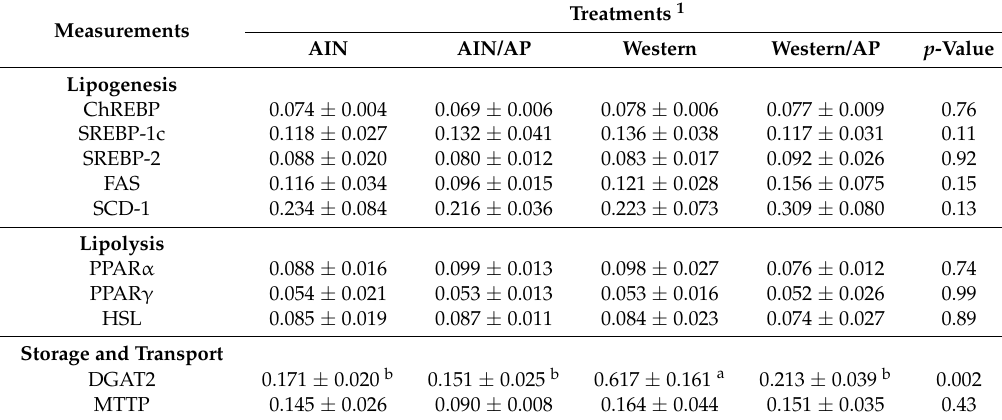
Table 6. Effect of consumption of different diets substituted with apple pomace (10% g/kg) by growing female rats on hepatic lipid metabolism gene expression following 8 weeks of